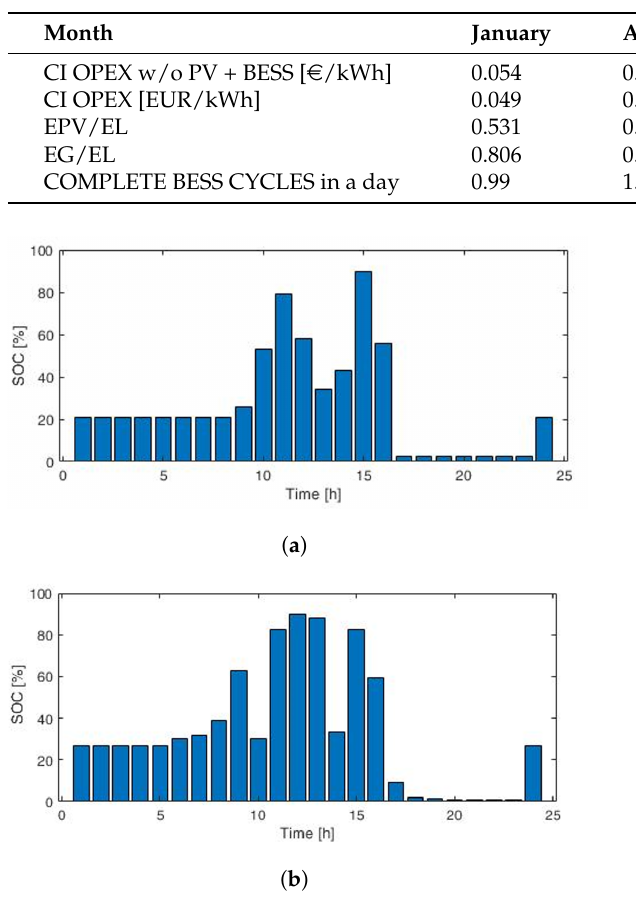
Table 4. CI OPEX and source power partition when BESS OPEX is null.